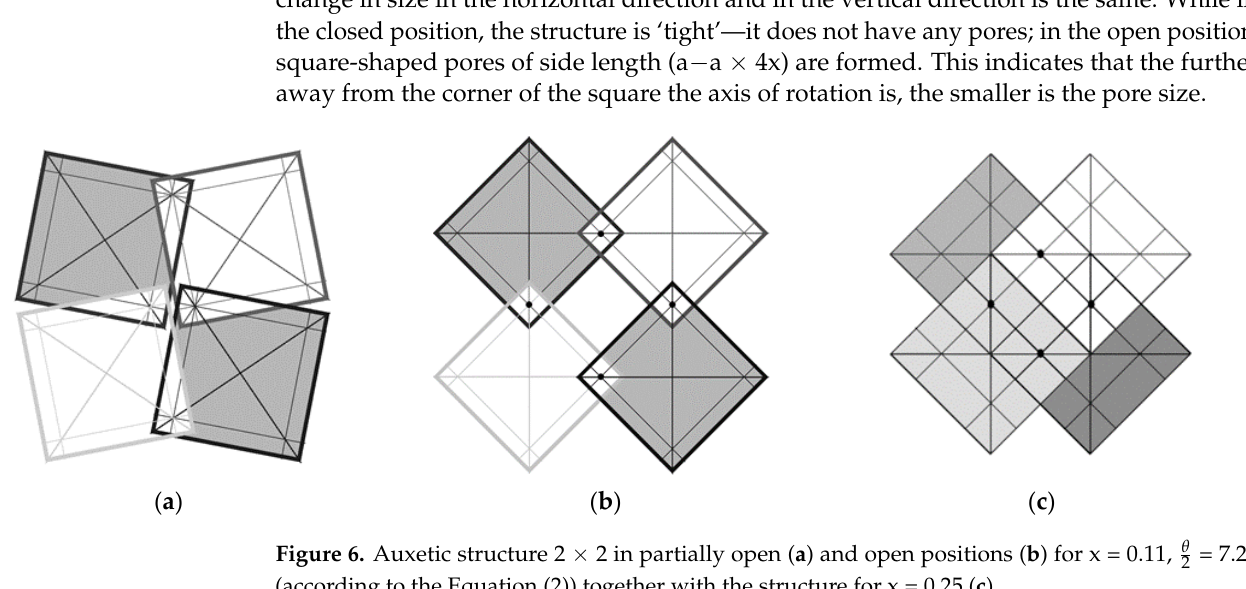
(according to the Equation (2)) together with the structure for x = 0.25 ( c ).